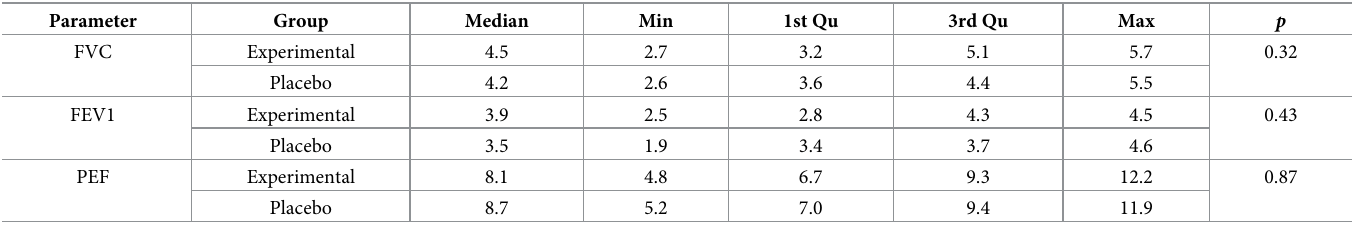
Table 3. Pulmonary parameters in experimental and placebo groups after OMT and